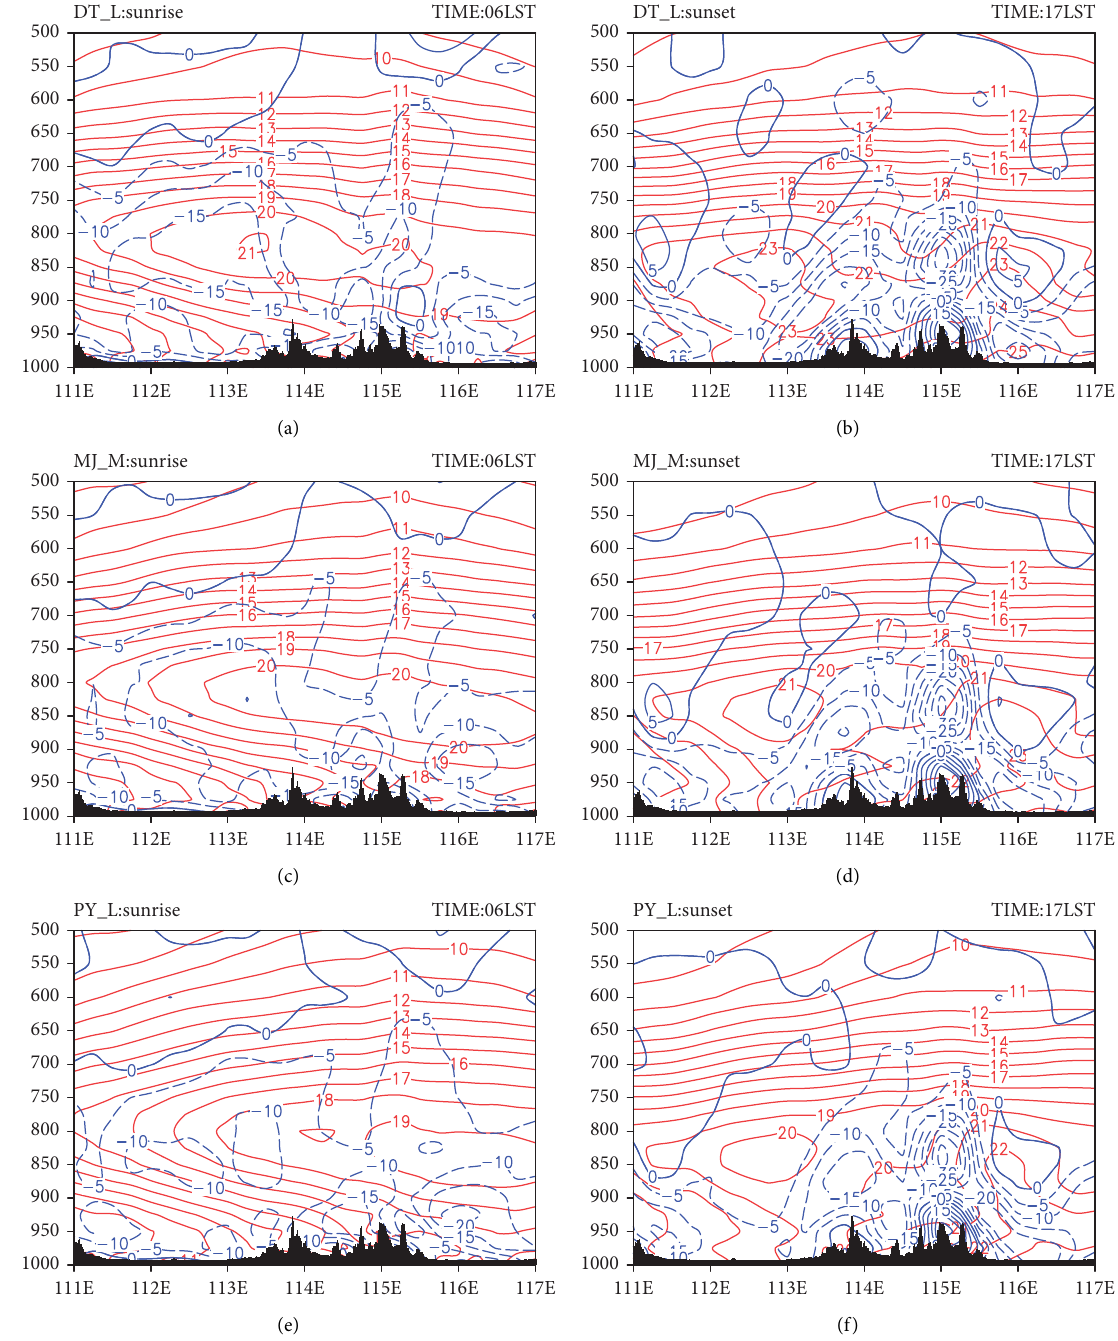
Figure 9: Te deviation (HHR days of each subregion minus non-HHR days) vertical sections (along 29 ° N) of divergence (blue line; 10 − 6 s − 1 ) and θ se (red line;